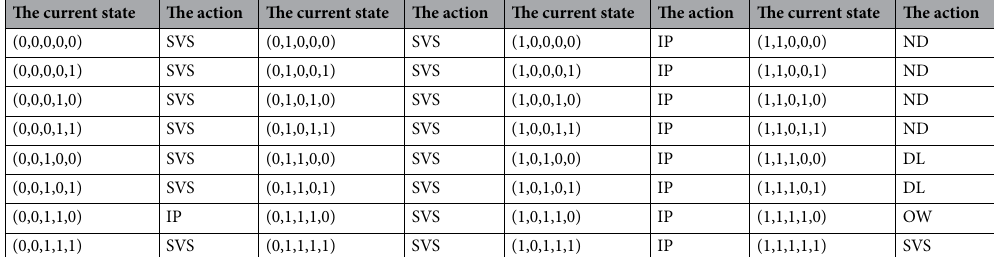
Table 6. The optimal decision rule at one decision moment in the DSV condition.